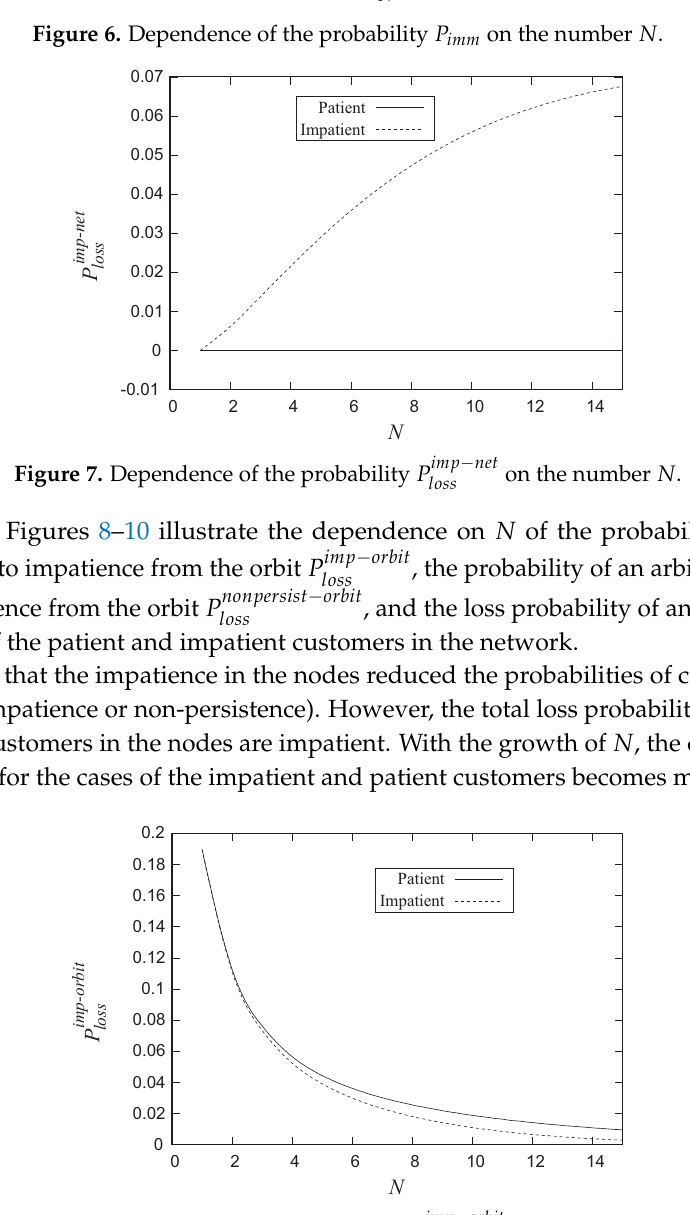
Figure 8. Dependence of the probability P imp